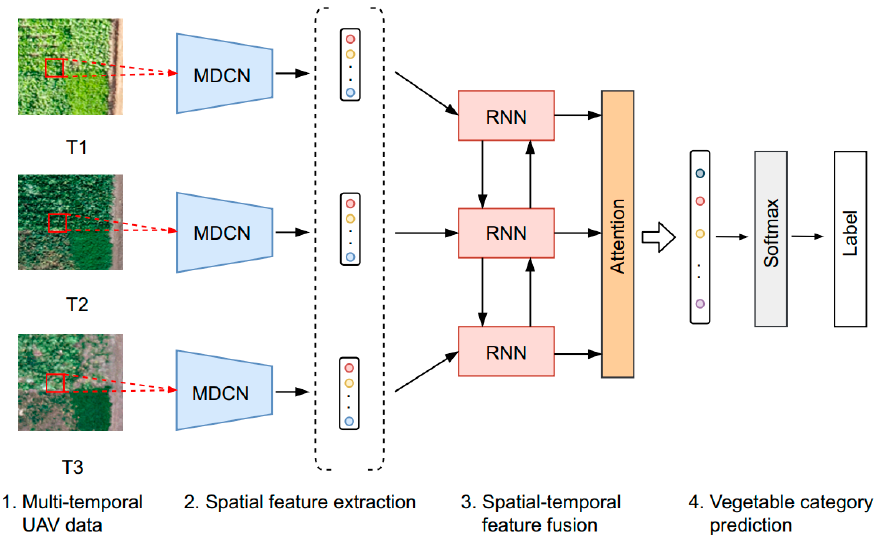
Figure 3. The overview of the proposed attention-based recurrent convolutional neural network (ARCNN) for vegetable mapping based on multi-temporal UAV data.